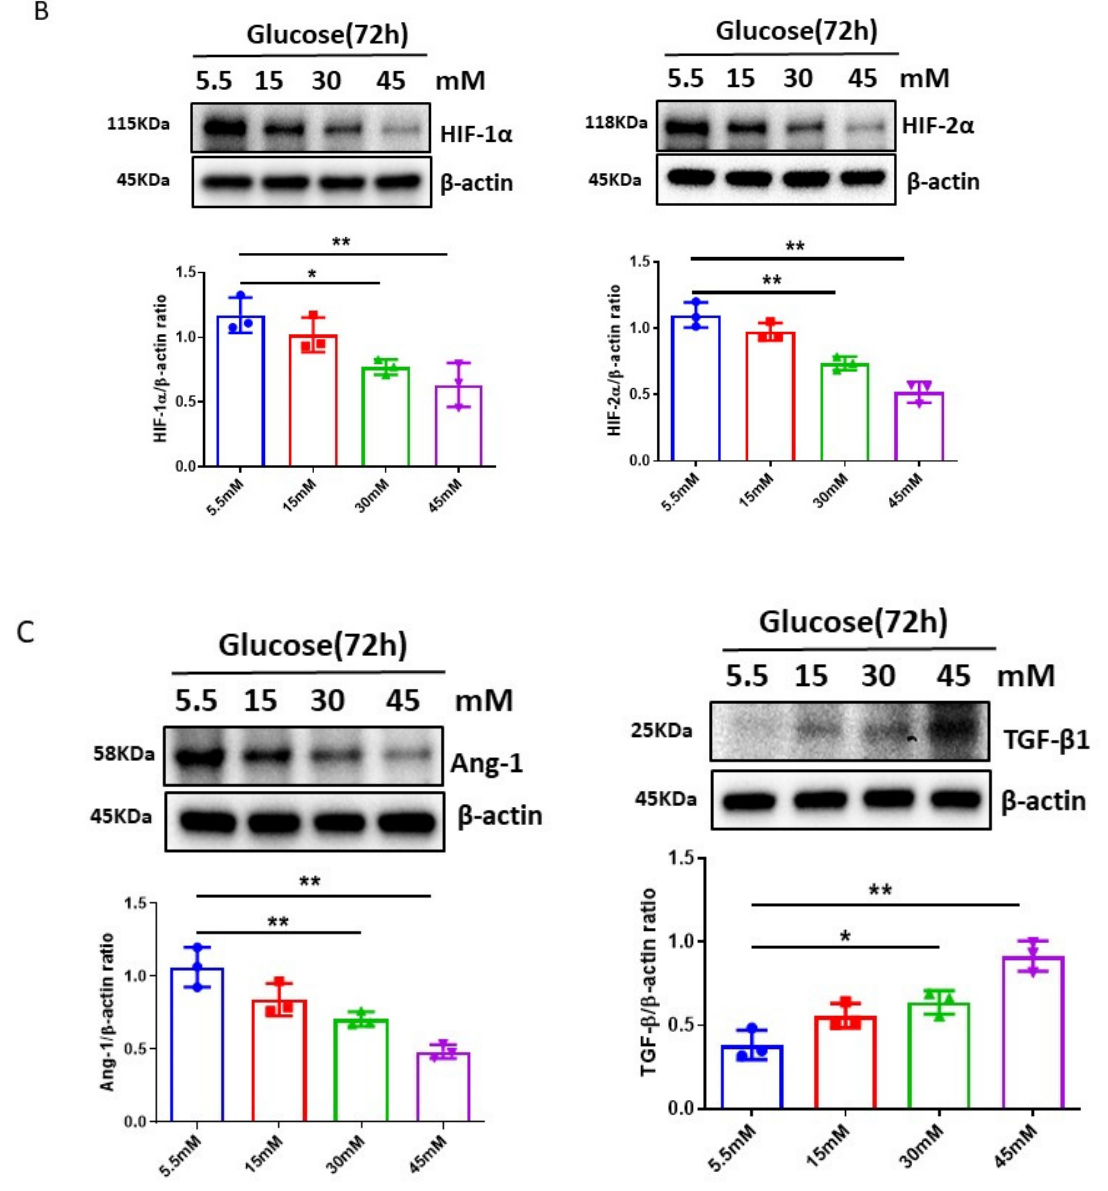
Figure 2. Dose response of high-glucose (HG)-induced upregulation of PHDs expression and reduc- tion in HIF- α expression in H9c2 cells. ( A ) Western blot analysis revealing that exposure of H9c2 cells to different concentrations of glucose (15, 30, 45 mM) for 72 h resulted in a dose-dependent increase in expression of PHD1 and PHD2 as compared to normal glucose (5.5 mM). Densitometries showed a significant upregulation of PHD1 and PHD2 expression at 30 mM and 45 mM. ( B ) Exposure of H9c2 cells to different concentrations of glucose (15, 30, 45 mM) for 72 h resulted in a dose-dependent reduction in HIF-1 α and HIF-2 α expression as compared to normal glucose (5.5 mM). Densitometries showed a significant reduction of HIF-1 α and HIF-2 α expression at 30 mM and 45 mM. ( C ) Exposure of H9c2 cells to different concentrations of glucose (15, 30, 45 mM) for 72 h resulted in a gradual increase in expression of TGF- β , but a significant reduction in Ang-1 expression as compared to normal glucose (5.5 mM). Densitometries showed that the expression of Ang-1 and TGF- β 1 was significant differences at 30 mM and 45 mM concentrations. All data represent mean ± SD (n = 3 per group, * p < 0.05 and ** p < 0.01). Circle, square and triangle were denoted the different experiment groups as indicated in the fi gures.